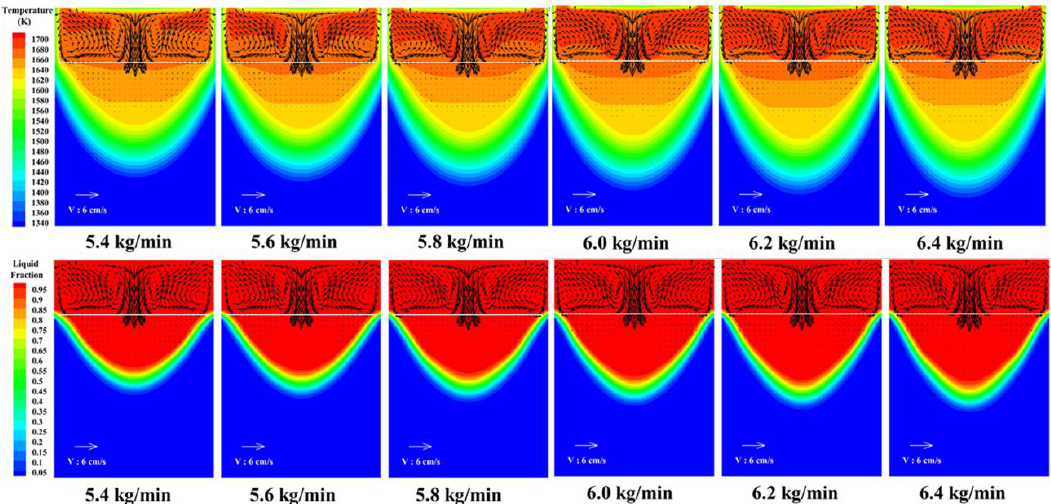
Figure 4. Changes in temperature field, velocity field and molten pool morphology.